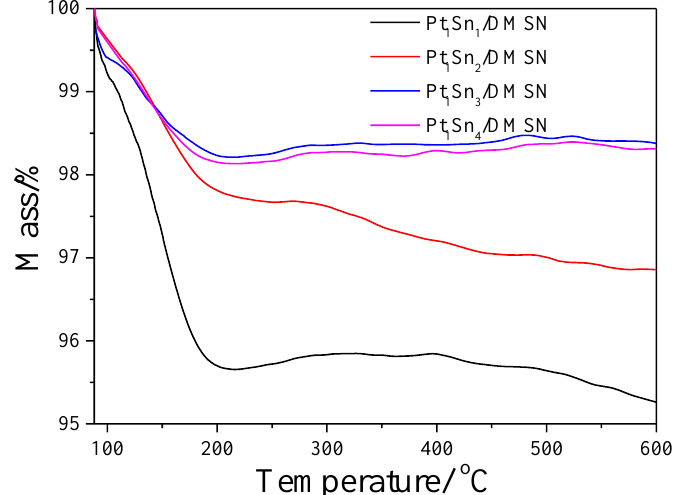
Figure 8. TG profiles of the spent PtSn/DMSN catalysts with different ratios of Pt and Sn.